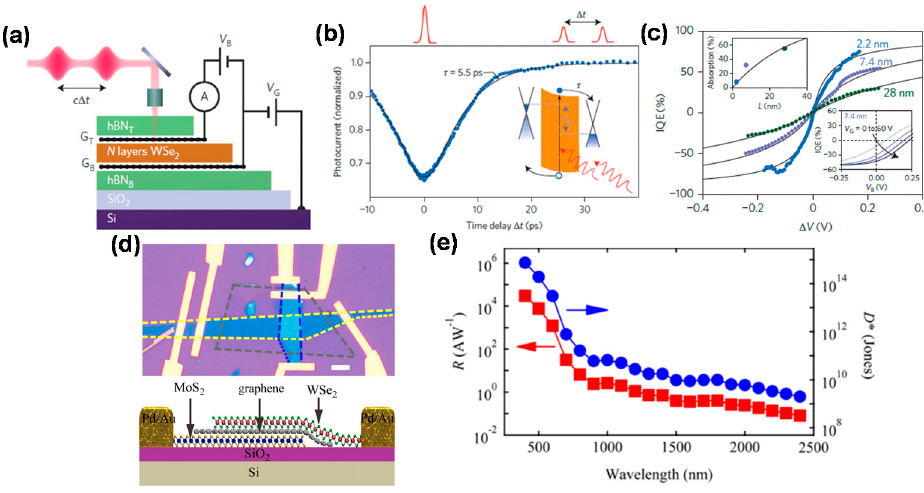
Figure 12. ( a ) Schematic illustration of the experimental time-resolved photocurrent set-up and cross-sectional view of the graphene/WSe 2 /graphene heterostructure; ( b ) Photocurrent as a function of time delay between two pulses; ( c ) IQE as a function of potential drop across theWSe 2 layer Δ V for devices with channel length = 2.2, 7.4, and 28 nm. Reproduced with permission for Figure 12a–c from 2016 Nature Nanotechnology [95]; ( d ) Top: optical image of a device fabricated based on van der Waals-assembled MoS 2 -graphene-WSe 2 . Bottom: schematic side view of the heterostructure; ( e ) Responsivity ( R ) and specific detectivity ( D* ) of a typical device for wavelengths ranging from 400 to 2400 nm. The device was tested in ambient air at V DS = 1 V and V g = 0 V. Reproduced with permission for Figure 12d,e from 2016 Nano Letters [100].